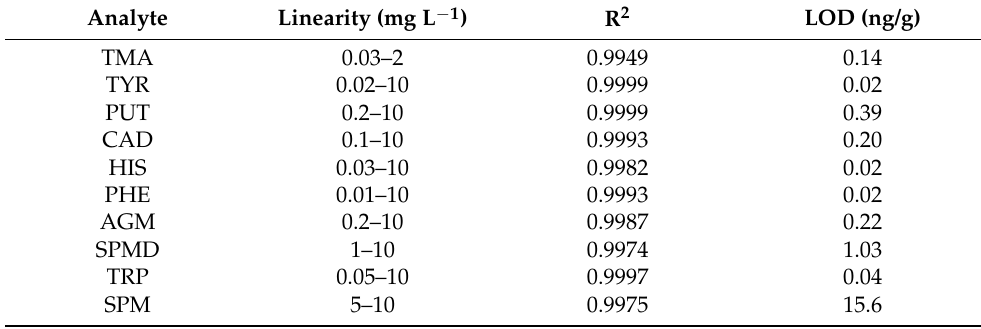
Table 2. Methods characteristics (linearity, R 2 , and limit of detection for each